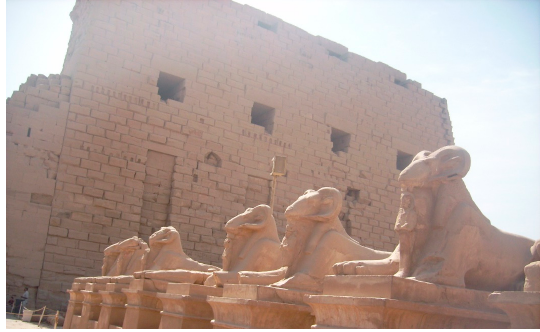
Figure 2. The main façade of Karnak temple at east Luxor.